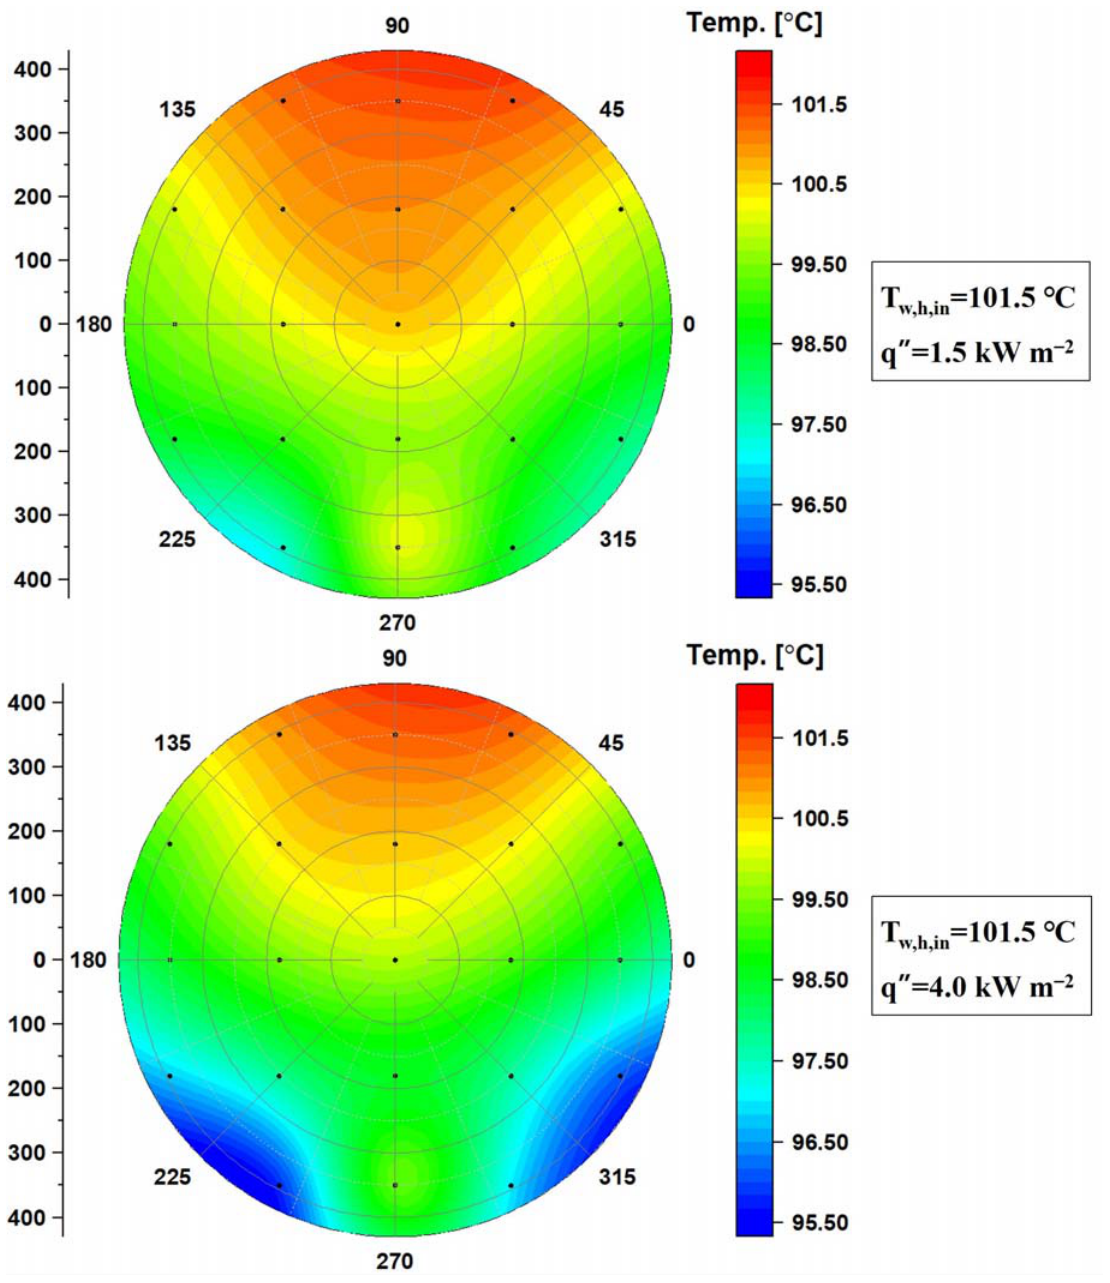
Figure 14. The temperature profile on the circular plate with respect to the Re at 101.5 °C.